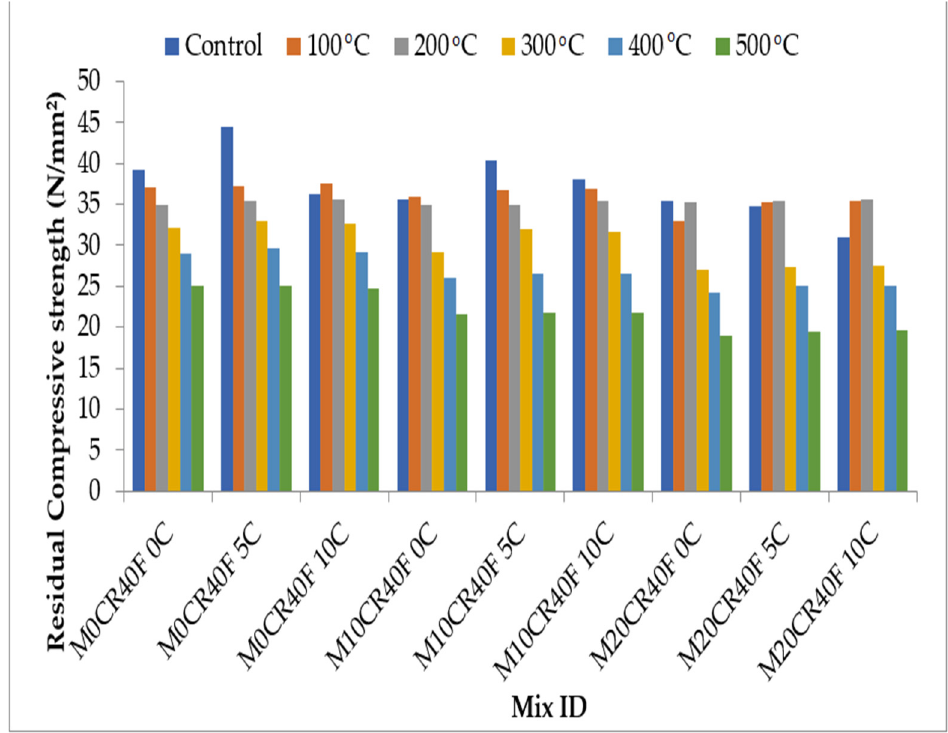
Figure 10. Effect of elevated temperature on the compressive strength of SCC mixes containing fly ash, CR, and CCW.